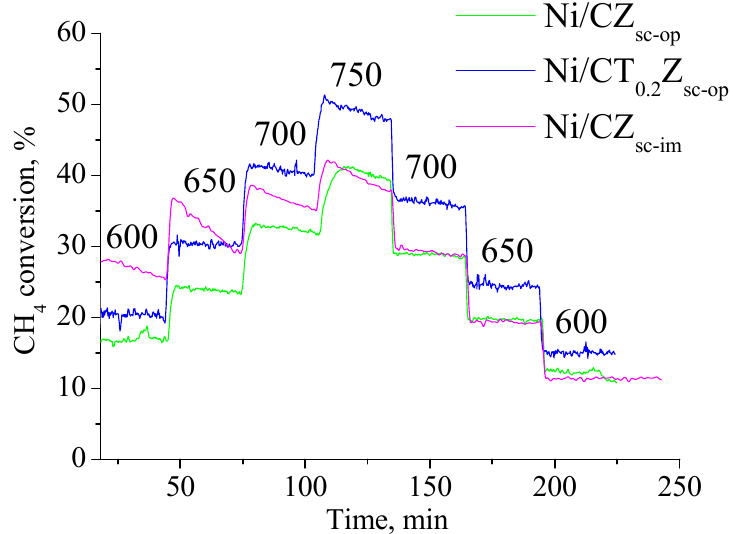
Figure 15. Comparison of effects of thermal cycling on CH 4 conversion in DRM over catalysts comprised of CZ and CTZ supports with Ni loaded by impregnation or one-pot methods.